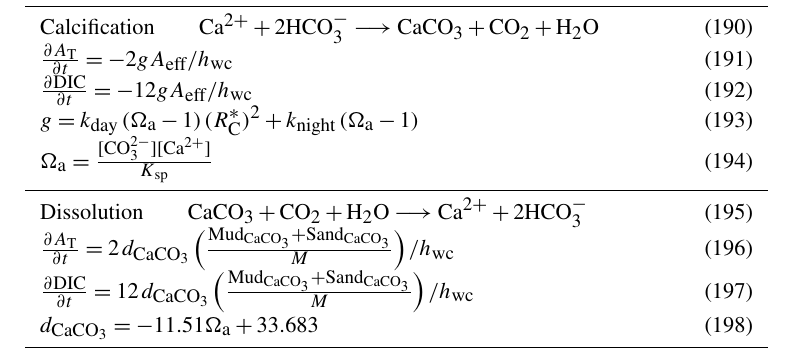
Table 32. Equations for coral polyp calcification and dissolution. The concentration of carbonate ions, [ CO 2 − rium carbon chemistry as a function of A T , DIC, temperature and salinity, and the concentration of calcium ions, [ Ca 2 + ] , is a mean oceanic value; 12gCmolC − 1 . Other constants and parameters are defined in Table 30.